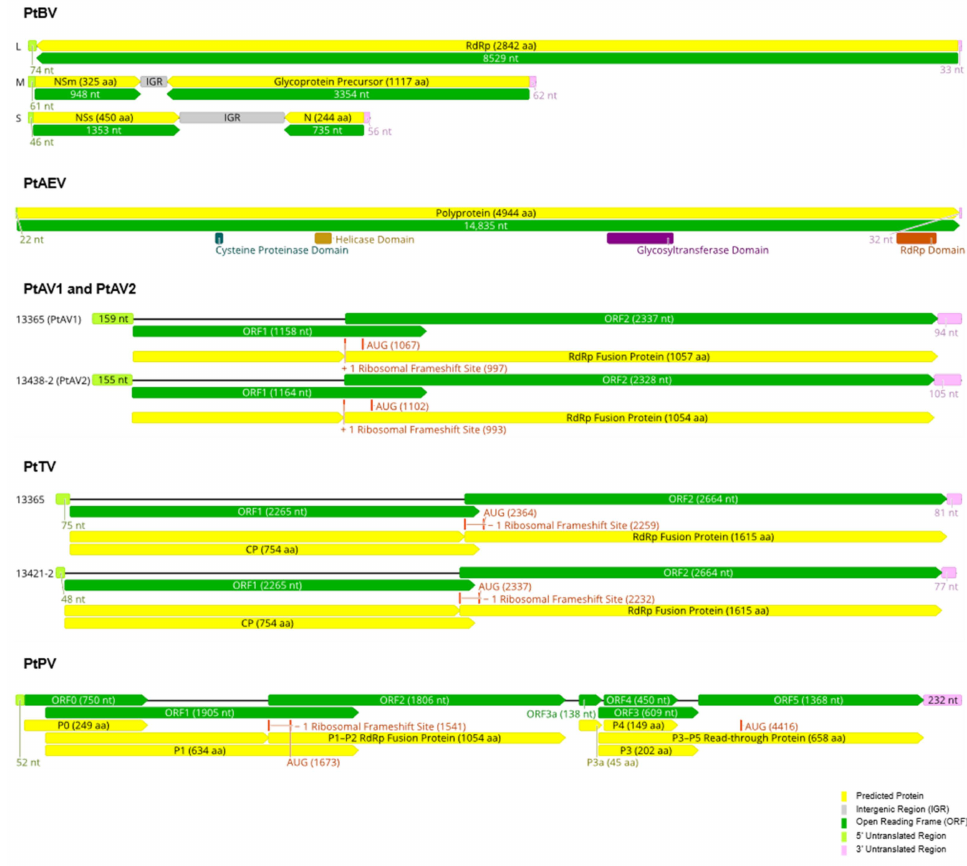
Figure 2. Genome architectures of the viruses identified in this study. Abbreviations are as follows: PtAEV, Pterostylis alphaendornavirus; PtAV1, Pterostylis amalgavirus 1; PtAV2, Pterostylis amal- gavirus 2; PtTV, Pterostylis totivirus; PtPV, Pterostylis polerovirus; RdRp, RNA-dependent RNA polymerase; NSm, non-structural protein, M segment; NSs, non-structural protein, S segment; N, nucleocapsid protein; CP, capsid protein; nt, nucleotide; aa, amino